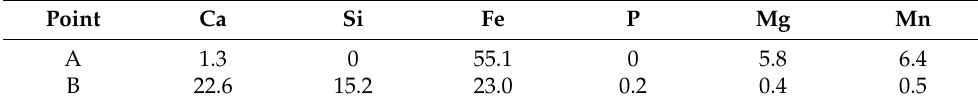
Figure 11. Morphology of residue after leaching in hydrochloric acid solution at pH 4. A,B: analysis point. Its composition is shown in Table 4. Table 4. Composition of mineral phases on the residue surface